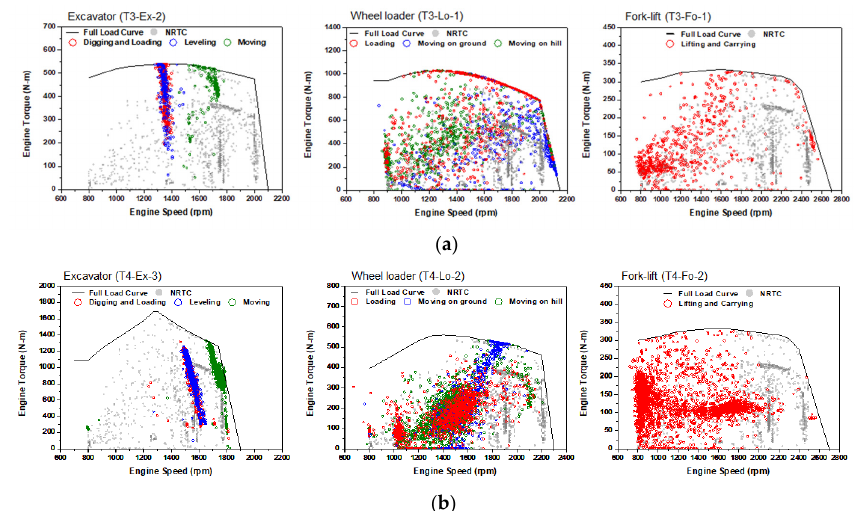
Figure 4. Engine torque with concern of engine speed for three difference construction machines operating the test conditions. ( a ) Tier 3; ( b ) Tier